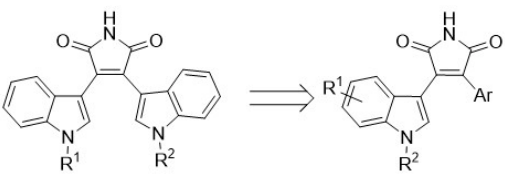
Figure 39. From BIM derivatives to BFIM and NIM analogues.